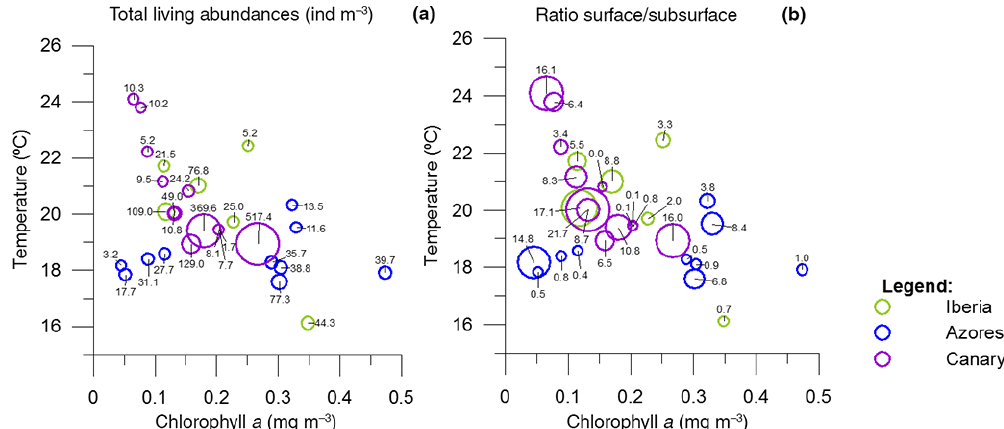
Figure 6. Total abundance given by circles size in the three regions from the study area of (a) living planktonic foraminifera and (b) the partitioning of the living population between surface and subsurface at the studied stations (Fig. 1) as a function of in situ mixed-layer interval mean temperature and mixed-layer interval mean chlorophyll a concentration. Samples from cruises M42/3, POS247/2, POS231/1 (Table 1) were not used, since only some species were counted in these samples and total living planktonic foraminifera abundances are not available. The depth partitioning of the population was calculated as the ratio of living planktonic foraminifera in the top 100m (or 150m where finer resolution was not available) and